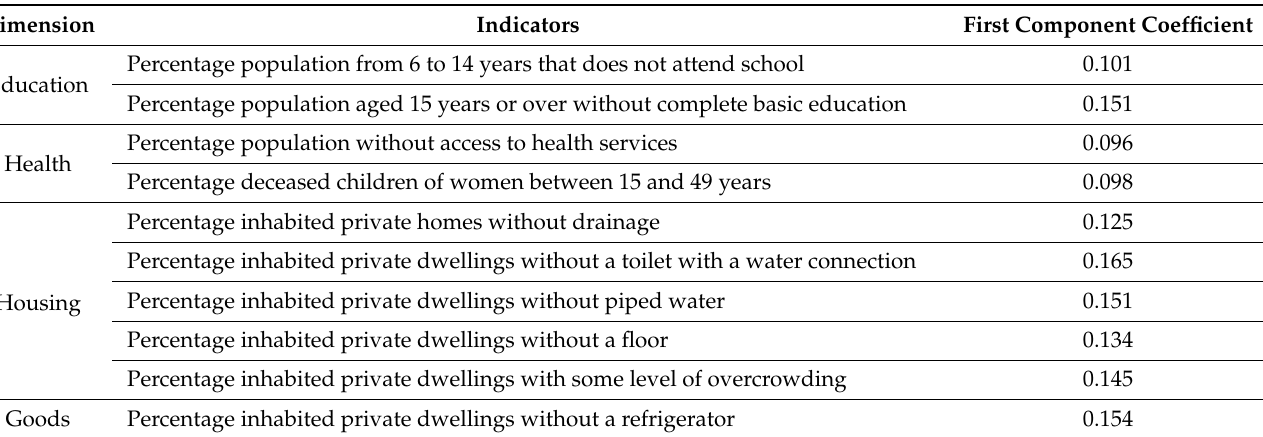
Table 5. Indicators used in the Urban Marginalization Index